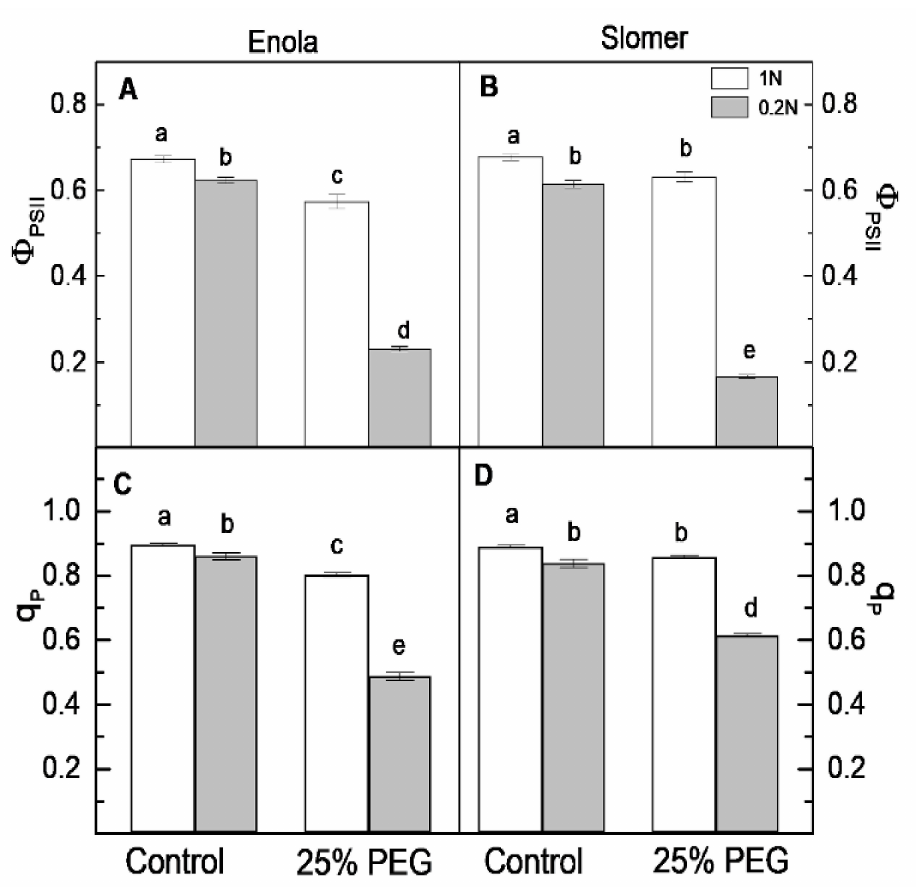
Figure 7. Effective quantum yield of PSII photochemistry, Φ PSII ( A , B ) and photochemical quenching coefficient, q P , ( C , D ) estimated in leaves of two wheat varieties (Enola and Slomer) grown with two nitrogen supply levels (1 N and 0.2 N) and subjected to osmotic stress with 25% PEG. Different letters represent significant differences at p < 0.05 ( n =